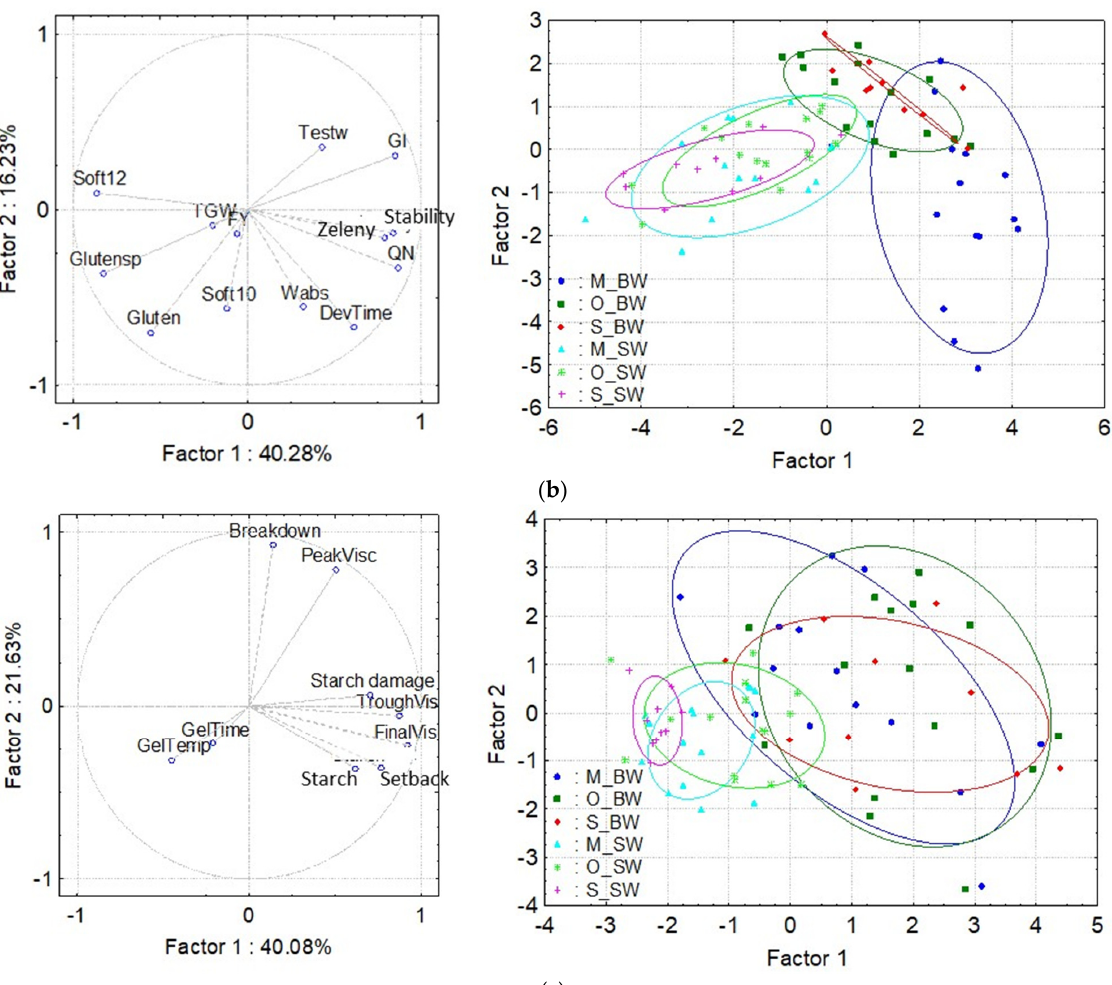
Figure 4. Principal component analysis of bread and spelt wheat varieties based on ( a ) bioactive compound, protein and starch content, ( b ) physical and quality traits and ( c ) starch ‐ related compo ‐ nents. M—conventional farming system in Martonvásár, Hungary, O—organic farming system in Hungary, S—conventional farming system in Serbia. BW—bread wheat, SW—spelt wheat. TO ‐ TAX—total arabinoxylan, WEAX—water ‐ extractable arabinoxylan, Soft10, 12—dough softening af ‐ ter 10 and 12 min, respectively, Glutensp—gluten spread, TGW—thousand kernel weight, Testw— test weight, FY—flour yield, Wabs—water absorption of the flour, DevTime—dough development